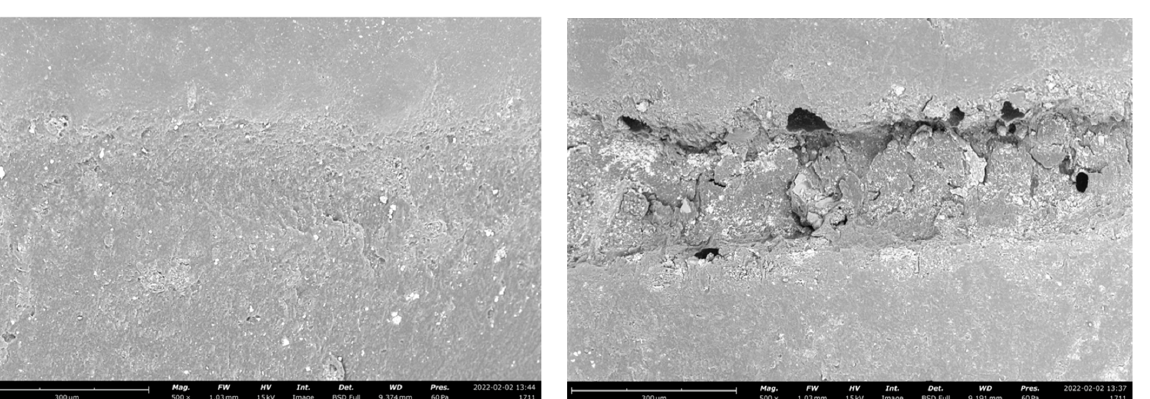
Figure 2. Representative SEM images of the adhesive interface of an adhesive crown before ( left ) and after ( right ) the chewing simulation test, restored with PICN. Figure 3. Representative SEM images of the adhesive interface of an occlusal veneer before ( left ) and after ( right ) the chewing simulation test, restored with PICN.